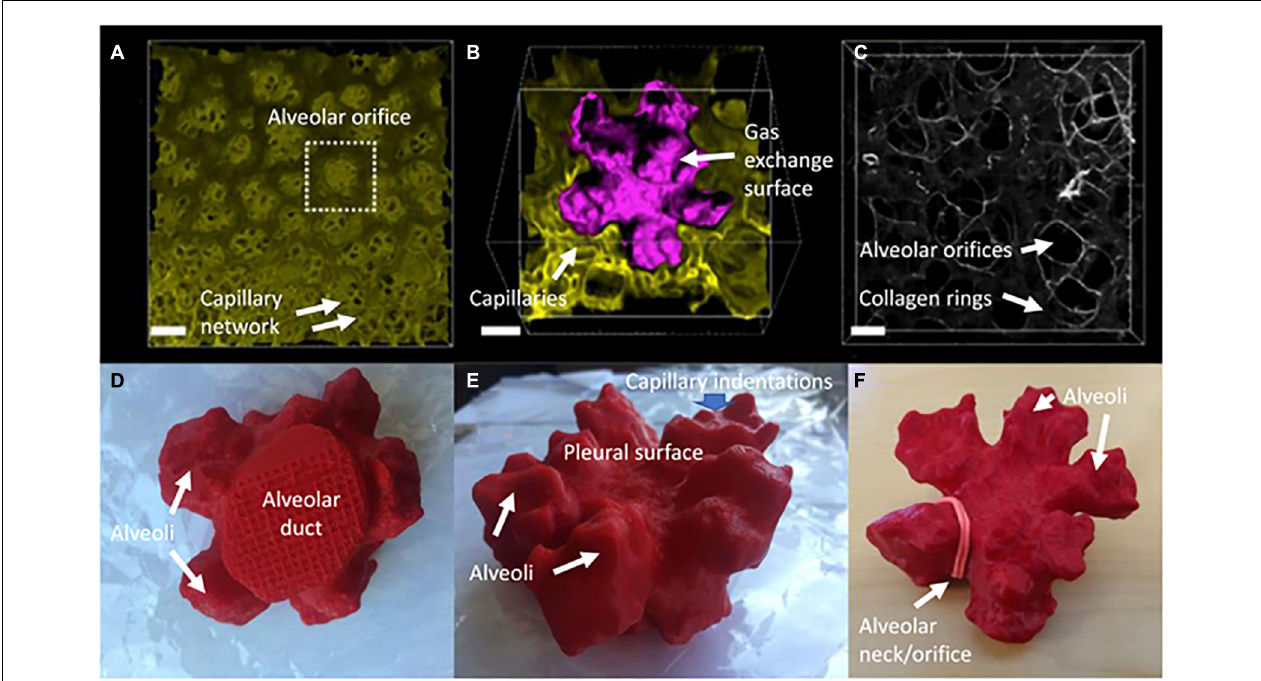
FIGURE 3 | Some key characteristics of peripheral alveoli of the mouse lung at 14 days postnatal age. (A) Digital reconstruction of a Vibratome serial section imaging microscopy (Vibra-SSIM) image of peripheral air sacs and their subjacent alveolar capillary plexi, looking outward from the mouth of the air sacs toward the pleural surface. The mouse in question has green membrane fluorescence. Scale bar is 50 microns. (B) The family of air sacs surrounded by the dotted box in (A) is shown enlarged with its gas exchange surface digitally rendered in purple to give contrast with the green background image. At this magnification the lumena of alveolar capillaries can be clearly seen in cross section within the lung mesenchyme. There are 5 alveoli connected to a common central lumen and this is typical for alveolar structures adjacent to the pleura. The irregular shape and surface rugosity of individual alveoli are also clearly shown. Scale bar is 25 microns. (C) Shows second harmonic generation (SHG) in white of collagen fibers located within the mesenchyme of alveolar mouths. Several groups of 3 or 5 air sacs are delineated by interconnected SHG collagen purse strings surrounding the mouths of individual air sacs. In some of them a bed spring like structure can be seen to extend proximally up the neck of a group of air sacs, surrounding the most distal portion of the alveolar duct. Scale bar is 25 microns. (D–F) Show 3-dimensional printed views of these air sacs rendered in purple in (B) and shown here as complementary 7 oblique views of a red plastic 3-dimensional solid object. (D) Shows the proximal to distal view of the round alveolar duct leading into a family of 5 alveoli. (E) Shows an oblique view of the irregular and rugose surface of the distal pleural surface of the family of 5 alveoli. (F) Shows a distal to proximal view of the five interconnected air sacs. An elastic band has been placed around the mouth of one air sac to illustrate where the collagen mouth rings shown in (C) lie in relation to the alveolar orifice.